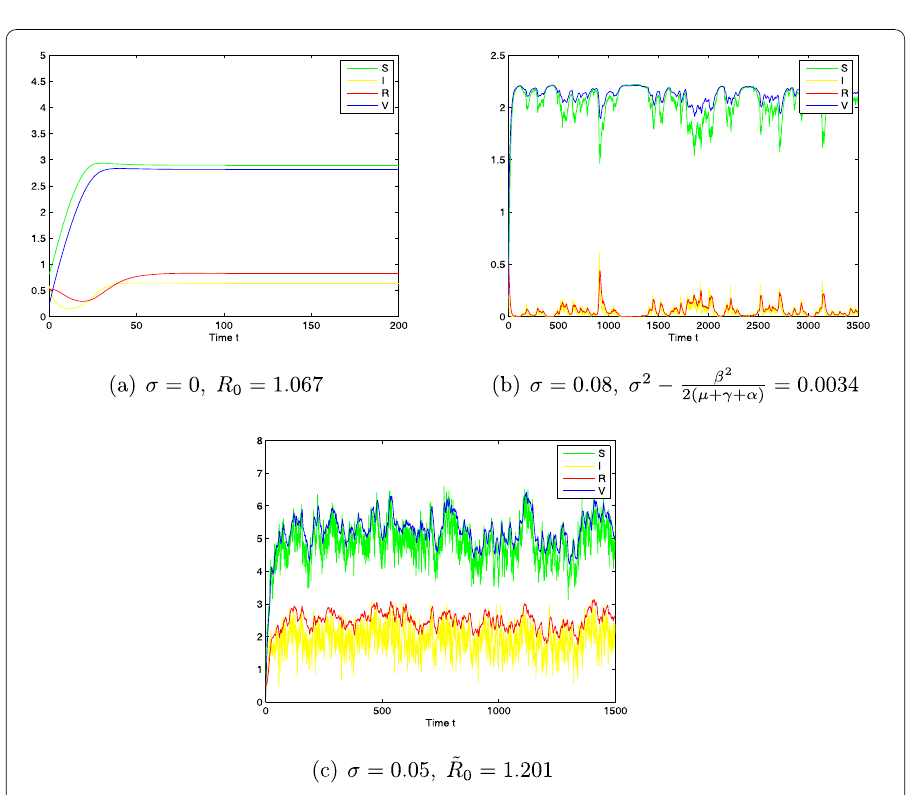
Figure 3 Simulation for paths S ( t ), I ( t ), R ( t ), and V ( t ) for the stochastic system and the corresponding deterministic system with initial value ( S (0), I (0), R (0), V (0)) = (0.5,0.06,0.5,0.5) and step size (cid:26) t = 0.001